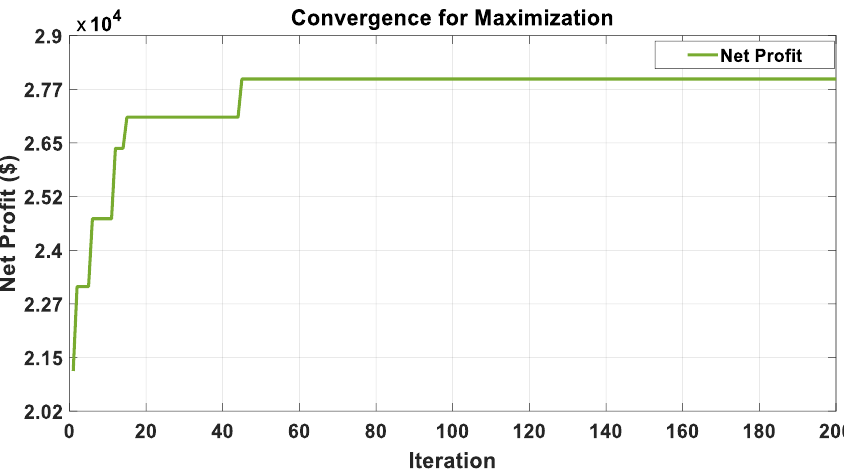
Figure 12. Convergence curve of MOBWO algorithm for Case I. Table 8. Comparison of emissions with different techniques for Case II.